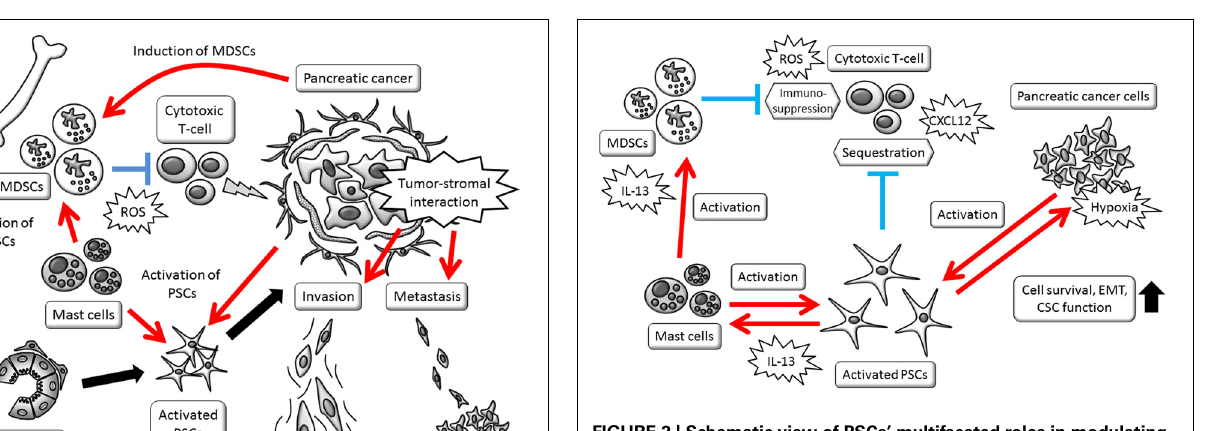
FIGURE 2 | Schematic view of PSCs’ multifaceted roles in modulating cell-to-cell interactions. Activated PSCs, mast cells, and MDSCs foam complex network that modify tumor microenvironment. CSCs, cancer stem cells; EMT, epithelial-mesenchymal transition; MDSCs, myeloid-derived suppressor cells; PSCs, pancreatic stellate cells; ROS, reactive oxygen